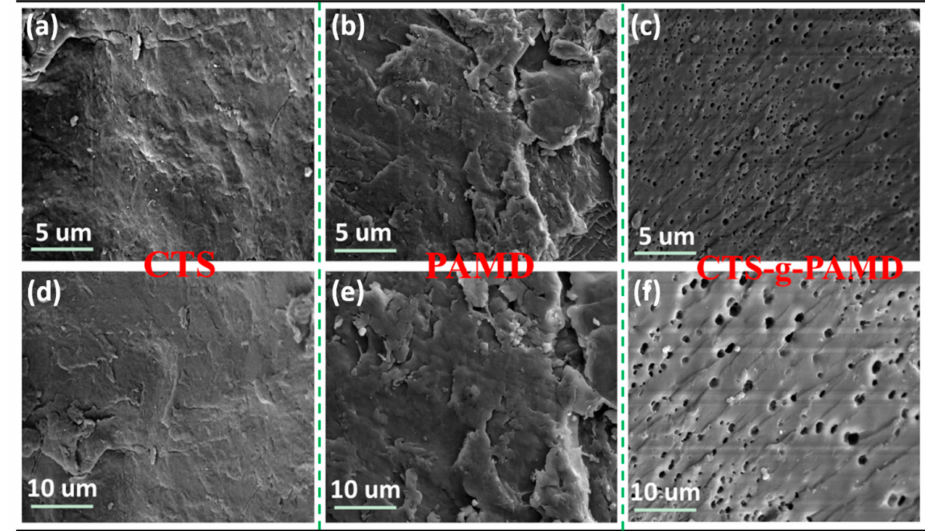
Figure 6. The surface morphology respectively at 8.0 kx and 4.0 kx magnification of the polymers ( a , d ) CTS, ( b , e ) PAMD and ( c , f )